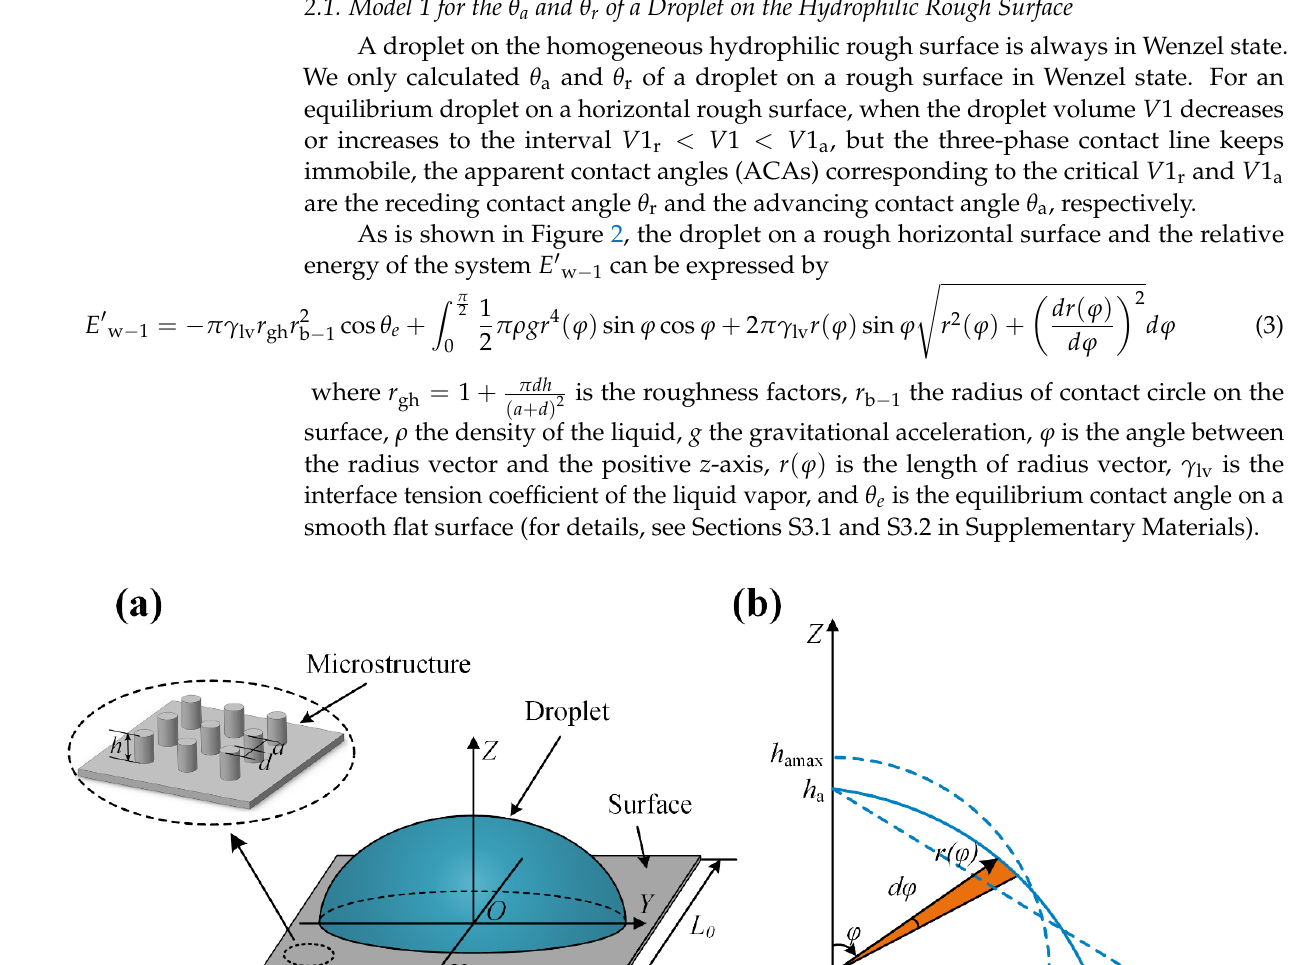
Figure 3. The sketch of calculations for a  and r  . ( a ) The moment the droplet volume increases to make the contact circle advance, and the ACA is a  . ( b ) The moment the droplet volume decreases to make the contact circle recede, the ACA is r  . Figure 4. The droplet on the inclined, hydrophilic rough surface.